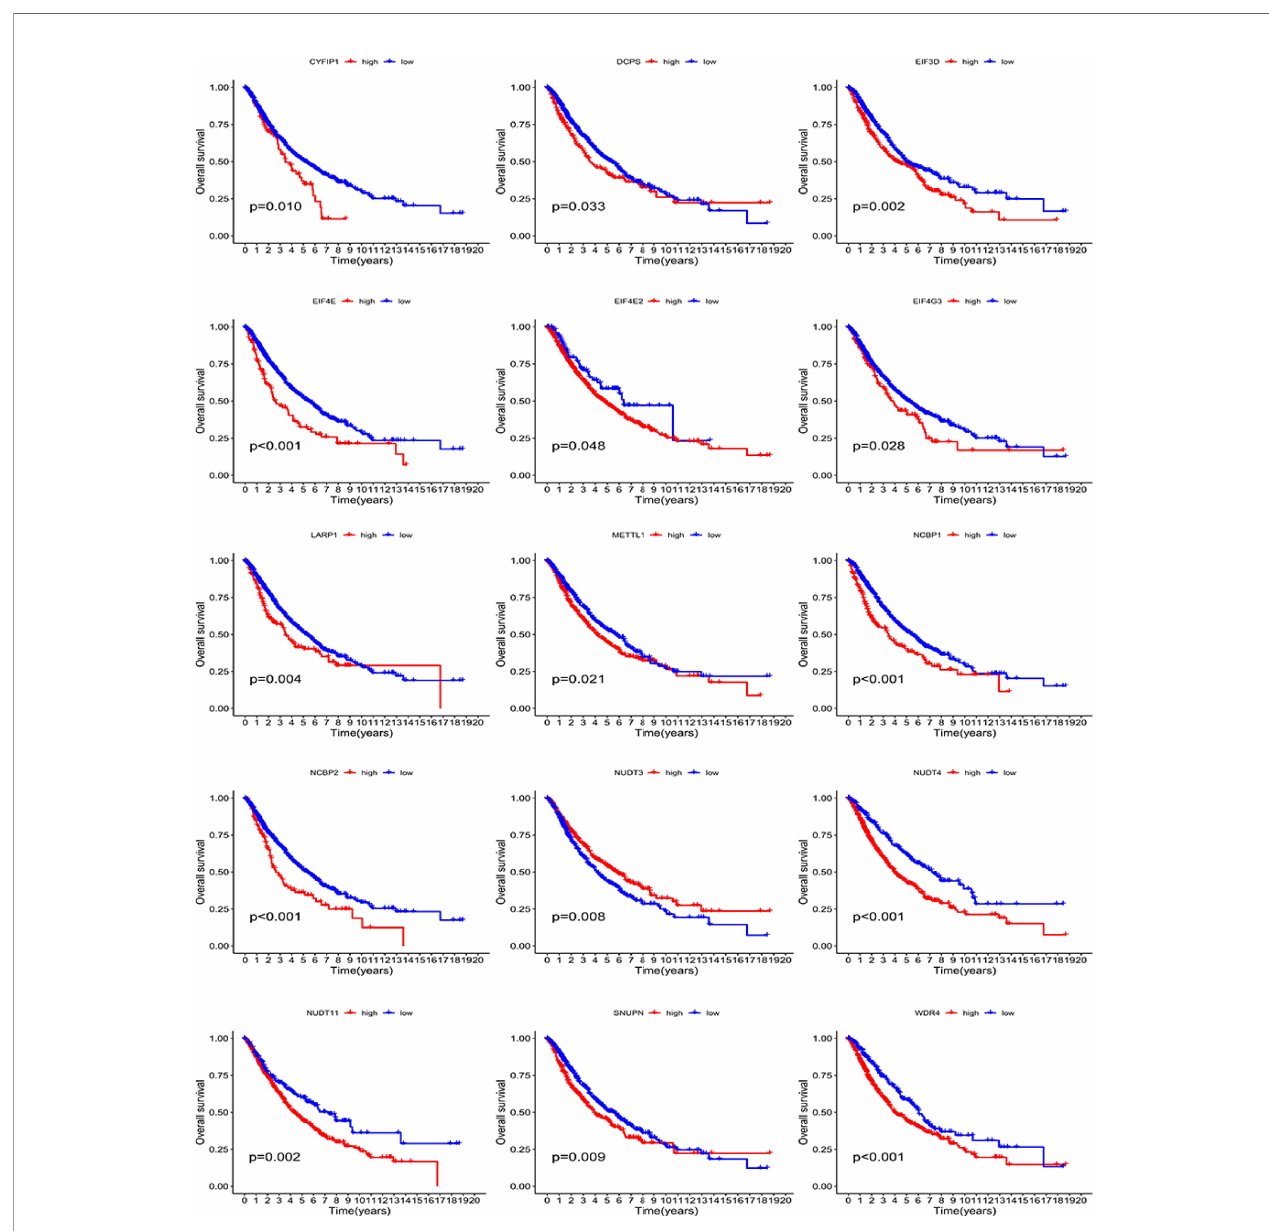
FIGURE 3 | The overall survival analysis based on the expression of each m 7 G-related